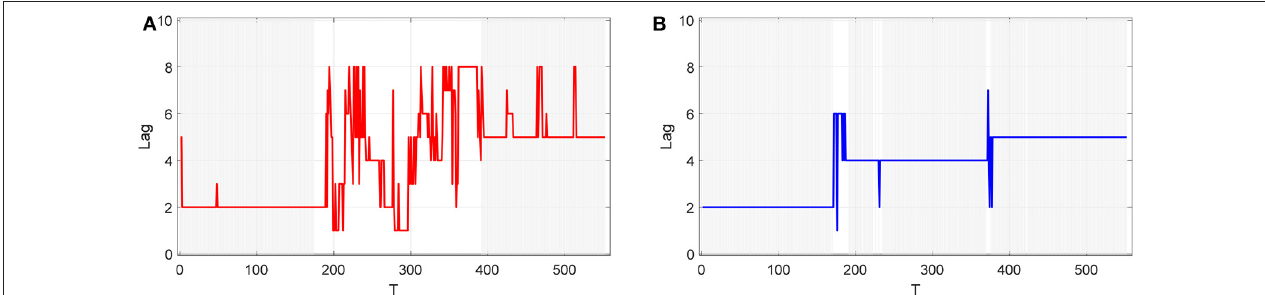
FIGURE 5 | Comparison of the Granger causality method based on a sliding window and the improved TE method. The widow length in both methods is W = 36, and the significant level is 1%. The Granger method can clearly identify k = 2 but cannot identify k = 4, and there is considerable noise interference when identifying k = 5. The improved TE method can clearly identify the three orders 2, 4, and 5. (A) Granger causality test based on the sliding window method. The gray part indicates that the p -value of the F statistic is < 1%, indicating that the causal relationship is significant in this area. (B) The result based on the improved TE method. The gray part indicates that the Z -score is higher than 3, which is equivalent to a significance level of p _ val < 0.01 [section Effective Transfer Entropy (ETE)].